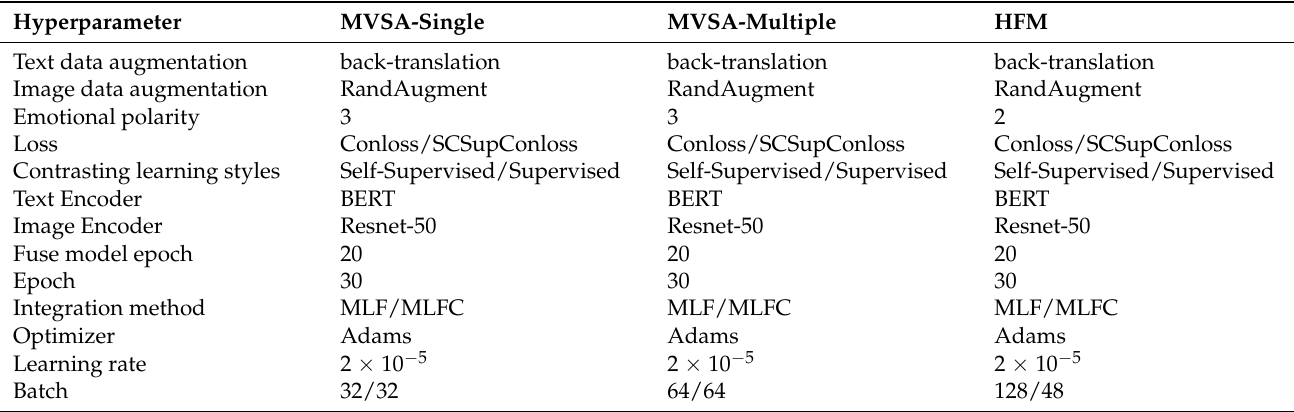
Table 1. Hyperparameter setting